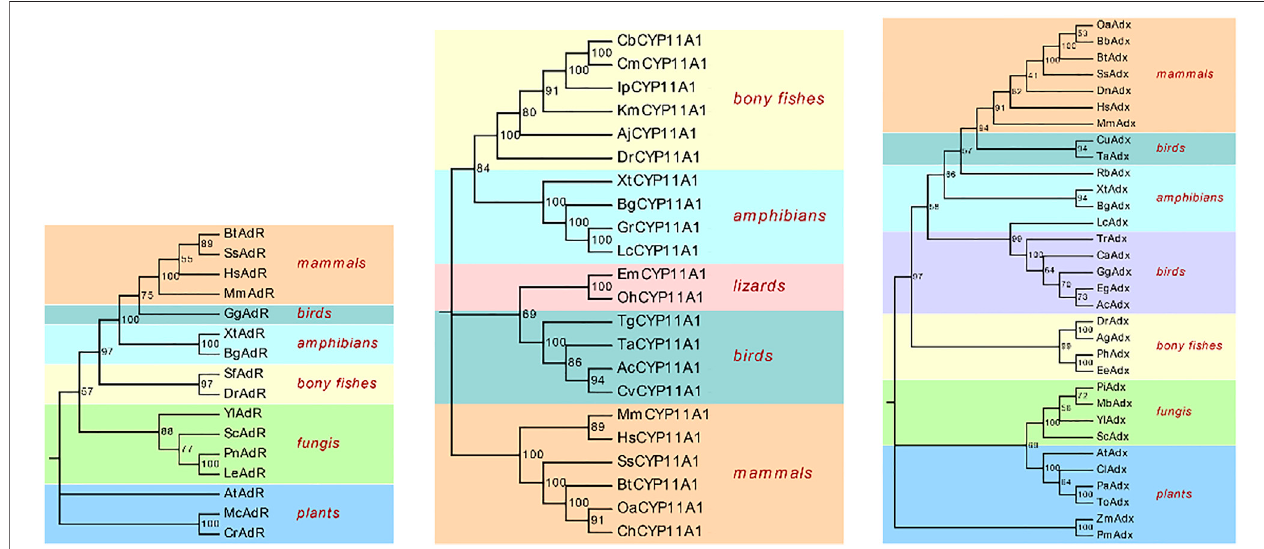
FIGURE6| PhylogeneticanalysisofP450sccsystem.ThereferencesequencesofCYP11A1,Adx,AdRfromdifferentspecieswereselectedfromNCBI, including mammals, amphibians, birds, bony fi sh, plants, fungi, lizards. Xt, Xenopus tropicalis ; Ta, Tyto alba ; Aj, Anguilla japonica ; Km, Kryptolebias marmoratus ; Gr, Glandirana rugose ; Bt, Bos taurus ; Gg, Gallus gallus ; Dr, Danio rerio ; Mm, Mus musculus ; Hs, Homo sapiens ; Lc, Lithobates catesbeianus ; Ss, Sus scrofa ;Oa, Ovis ammon ; Ch, Capra hircus ; Cb, Clarias batrachus ; Cm, Clarias magur ; Ip, Ictalurus punctatus ; Ac, Anser cygnoides ; Tg, Taeniopygia guttata ; Cv, Colinus virginianus ; Oh, Ophiophagus Hannah ; Em, Eublepharis macularius ; Dn, Dasypus novemcinctus ; Bb, Bubalus bubalis ; Lr, Labeo rohita ; Ag, Anabarilius grahami ; Ph, Pangasianodon hypophthalmus ; Ee, Electrophorus electricus ; Eg, Egretta garzetta ; Tr, Turdus ru fi ventris ; Ca, Calypte anna ; Ac, Antrostomus carolinensis ; Cu, Catharus ustulatus ; Rb, Rhinatrema bivittatum ; Yl, Yarrowia lipolytica ; Sc, Saccharomycescerevisiae ; Pi, Penicillium italicum ; Mb, Metarhizium brunneum ; Pa, Parasponia andersonii ; To, Trema orientale ; Cl, Carex littledalei ; Zm, Zea mays ; Pm, Panicum miliaceum ; At, Arabidopsis thaliana ; Sf, Salvelinus fontinalis ; Mc, Micractinium conductrix ; Cr,